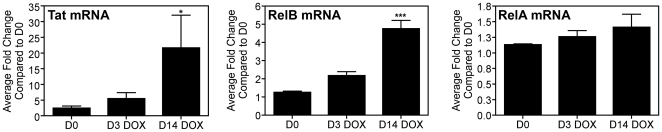
Transgenic expression of Tat induces RelB synthesis in mouse brain.6-week old Tat-transgenic mice were induced with doxycycline for the indicated periods of time. Total RNA was extracted from brain tissue, reverse transcribed using oligo-dT primers, and subjected to Real-Time SYBR Green RT-PCR amplification. Fold induction of Tat, RelB and RelA mRNA species was normalized to GAPDH and presented as a function of the expression level in D0 samples. Data represent mean ± SEM of four replicates for D0 and D14 samples, and five replicates for D3 samples. Statistical significance (***, p<0.001 or *, p<0.05) is denoted as compared to D0 samples.